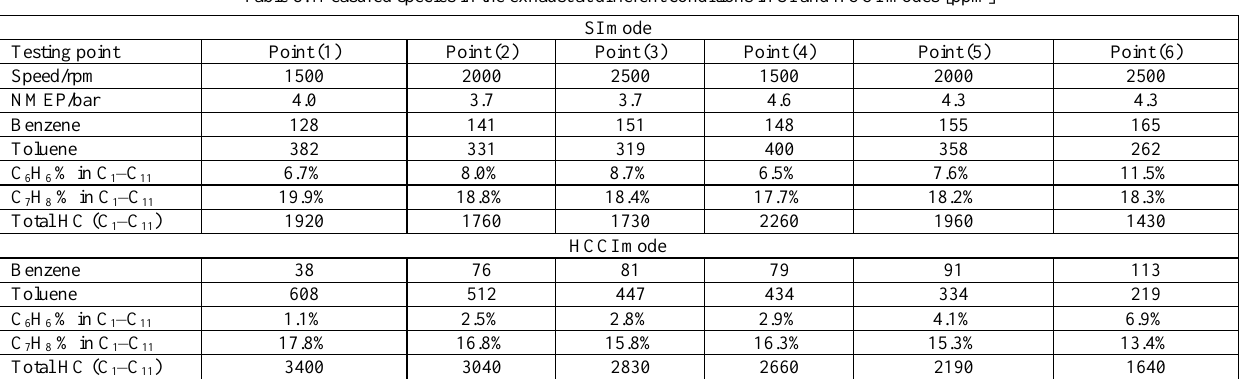
Table 8. Measured species in the exhaust at different conditions in SI and HCCI modes